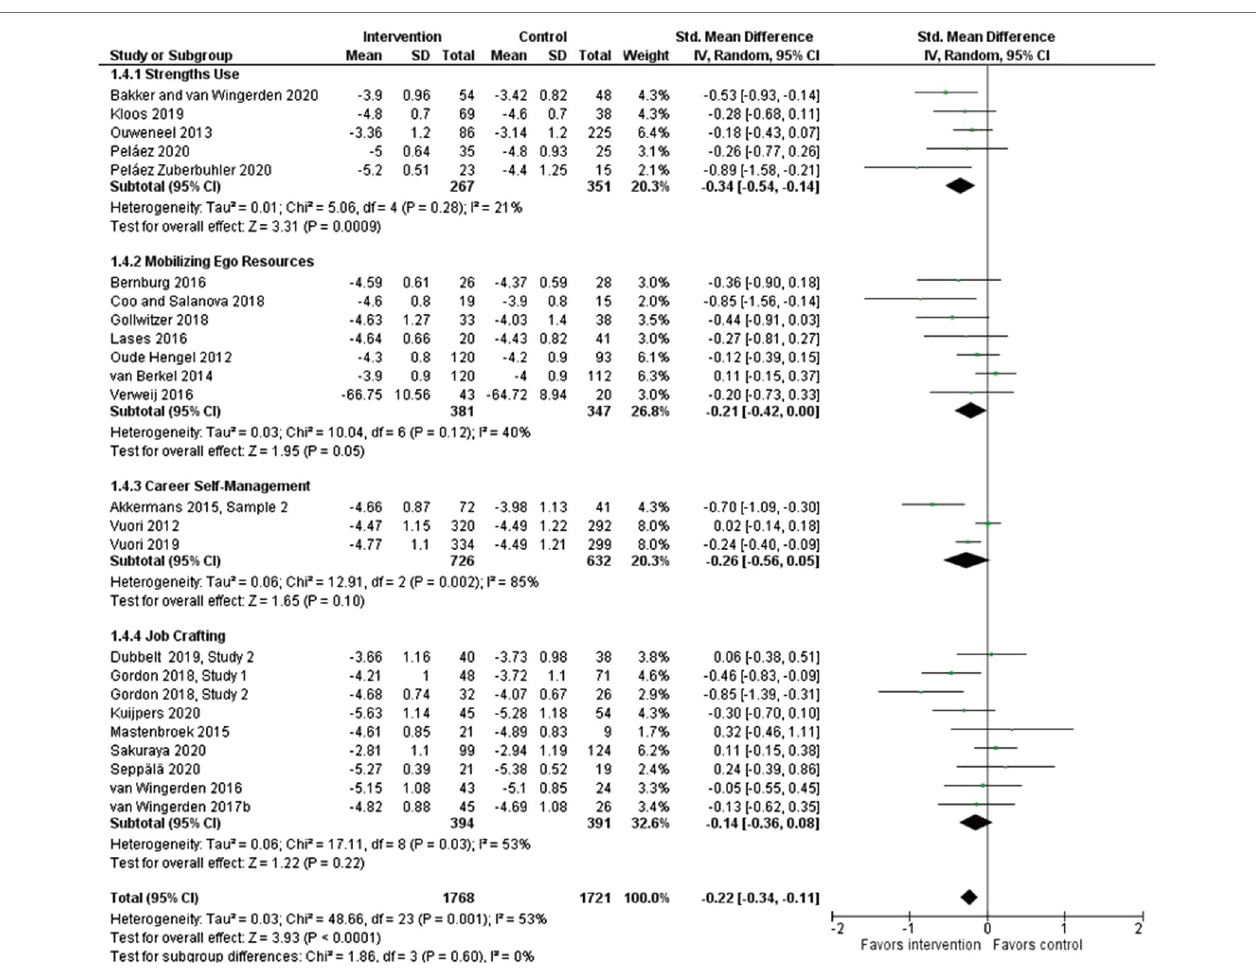
FIGURE 4 | Effect of bottom-up, resource-developing interventions versus no-intervention controls on work engagement according to intervention